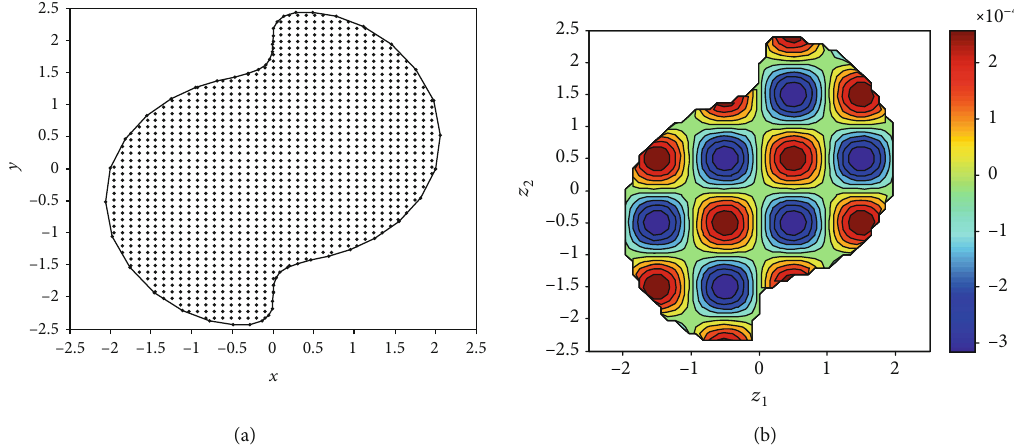
Figure 13: (a) Irregular domain and (b) numerical solution for the Problem 7.